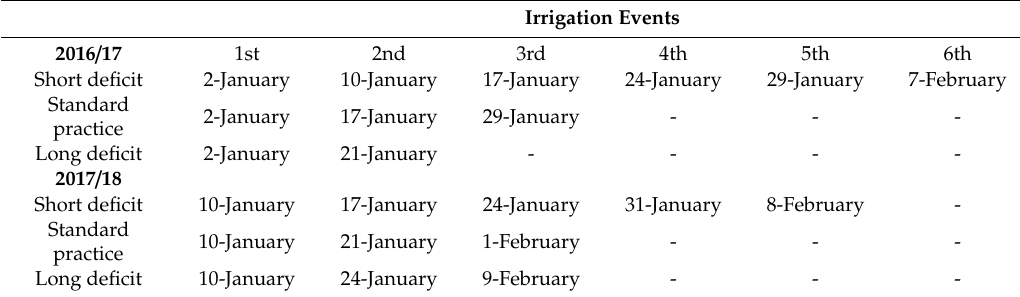
Figure 2. Distribution of the treatments in the field. The red rectangle indicates the area used for the study presented here. The black dots indicate the monitoring stations, each with two matric potential sensors within the main plots 4, 5 and 6. Subplots with the highest nitrogen (N) rates received 277 and 309 kg N ha − 1 the first and second growing seasons, respectively. Subplots with the lowest nitrogen (N) rates received 180 kg N ha − 1 in the 2016 / 17 season and 244 kg N ha − 1 in the 2017 / 18. Table 1. Dates when irrigation events occurred in each treatment during the period of measurements within the 2016 / 17 and 2017 / 18 seasons.